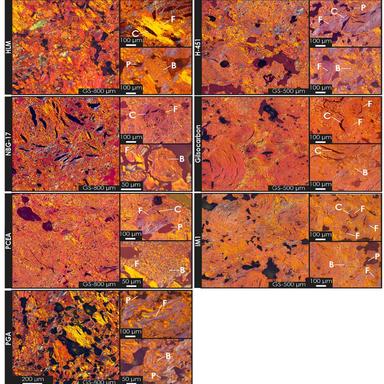
Polarized optical micrographs of medium-fine graphite grades. B – Binder, C – Crack, F – Filler, P –Pore. The label GS denotes the grain size of the material; the scale bar in NBG-17 applies to all low magnification micrographs presented.